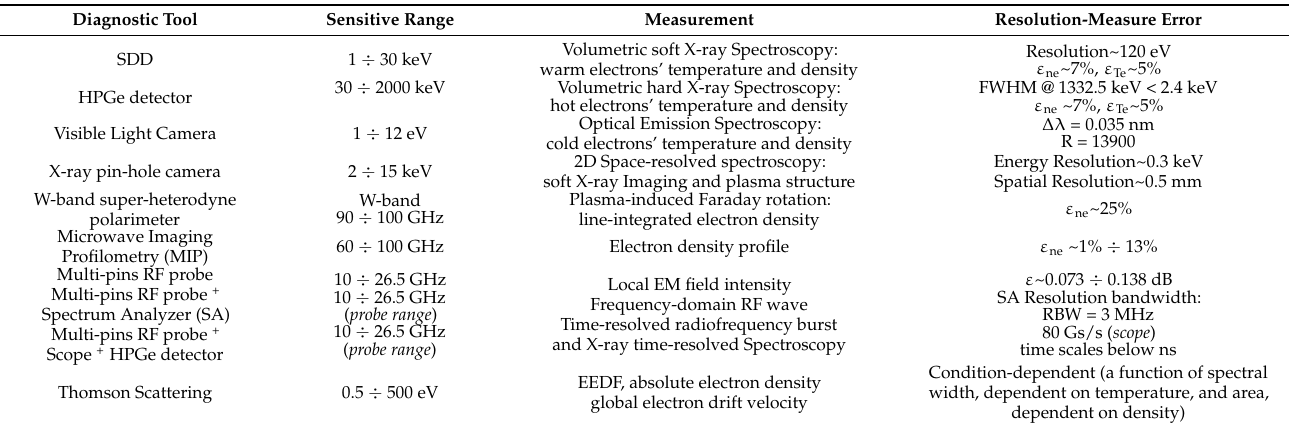
Table 2. List of non-invasive diagnostic tools used in the PANDORA setup, with their most relevant characteristics in terms of sensitivity range, measured plasma parameters, and detection resolu- tion. All these tools have been widely tested in dedicated testbenches, while Thomson Scattering diagnostics’ implementation is ongoing in the PANDORA